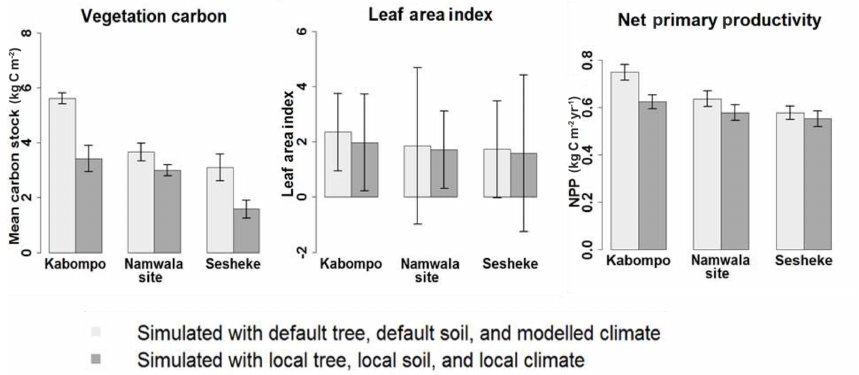
Figure 6. Mean annual vegetation carbon stocks, LAI and NPP simulated with local and default soil and tree parameter values, and forcing of the model with local and modelled climate data. Simulations were done for the period 1959–2003. This figure only shows values simulated with a combination of default tree, default soil, and modelled climate data and also a combination of local tree, local soil, and local climate data. The reader is referred to the Supplement (Fig. S6) for the results of the effects of each of these default tree parameters, default soil parameters, local tree, local soil parameters, local climate, and modelled climate data.